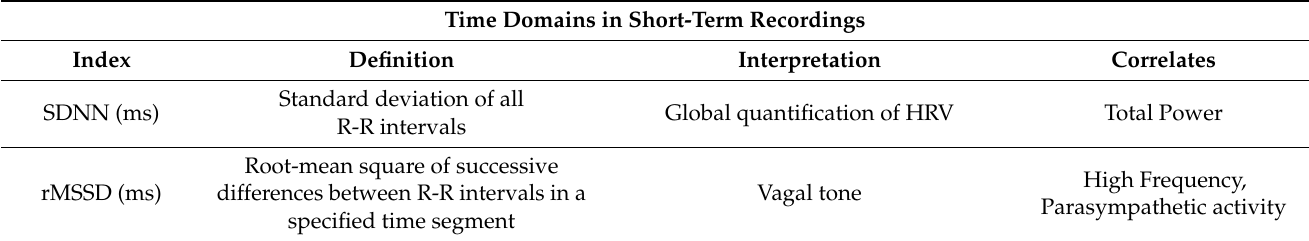
Table 1. Definitions basic time and frequency domain heart rate variability metrics [27,69]. Time Domains in Short-Term